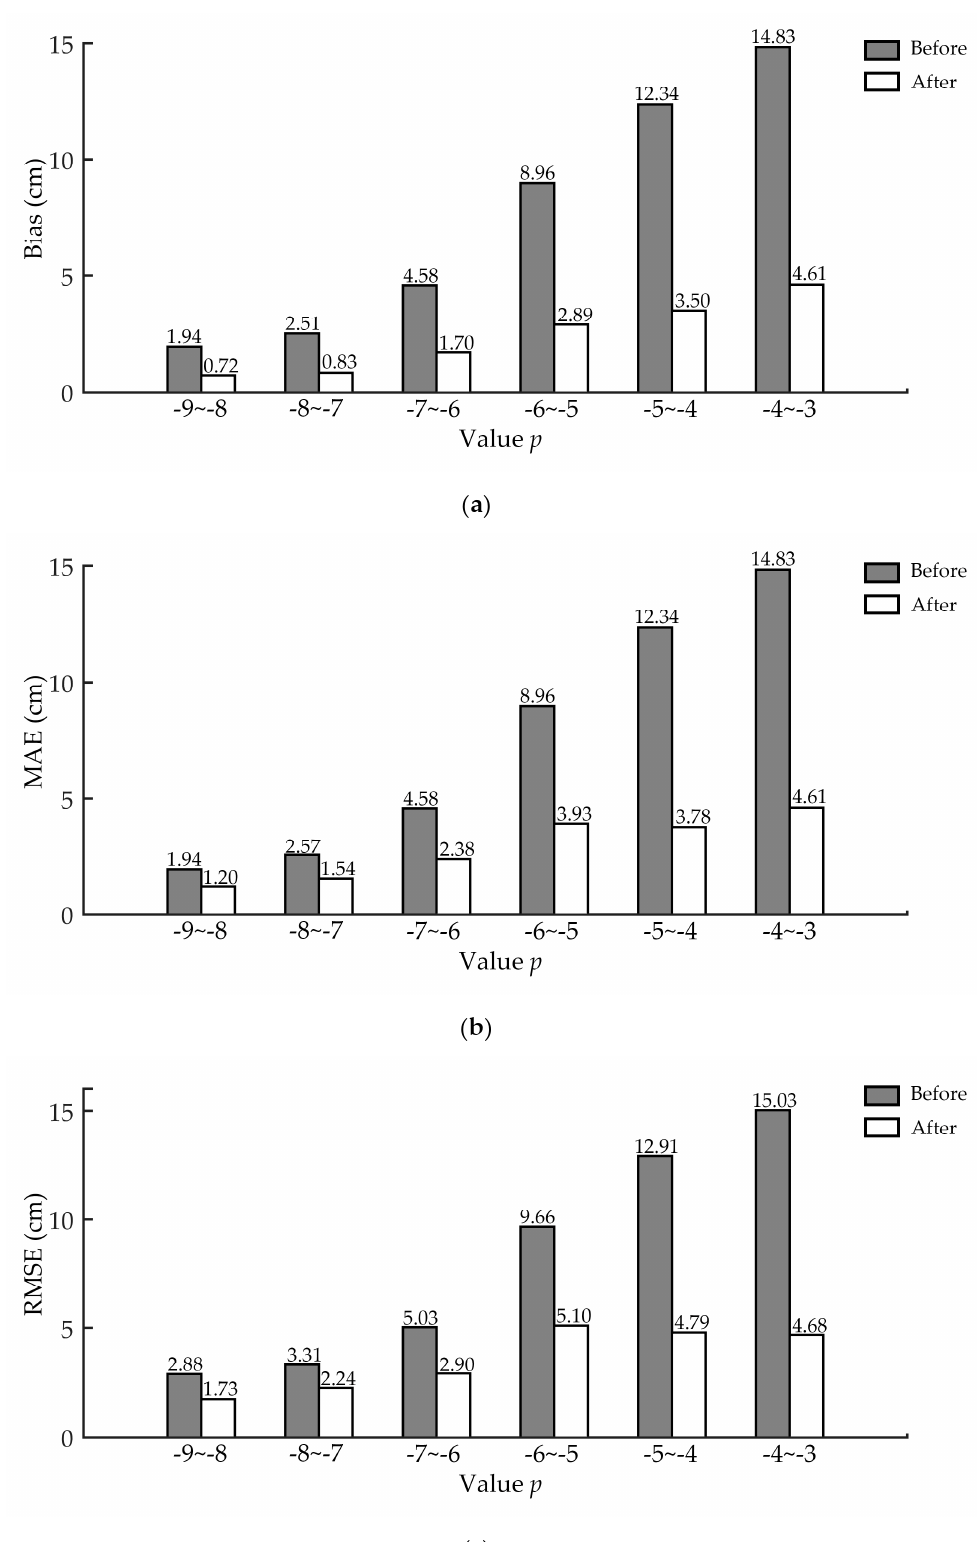
Figure 11. DBH estimation accuracy for horizontal point cloud slices of different quality before and after applying ANPDA based on ( a ) bias, ( b ) MAE, and ( c ) RMSE. The black bars show DBH estimation error before applying ANPDA, while the red bars show the error after applying ANPDA. Table 5 shows the average error reduction and the effective rate of applying ANPDA. Aside from the class with a p -value of − 4 to − 3, which only contained three-point clouds, the average error